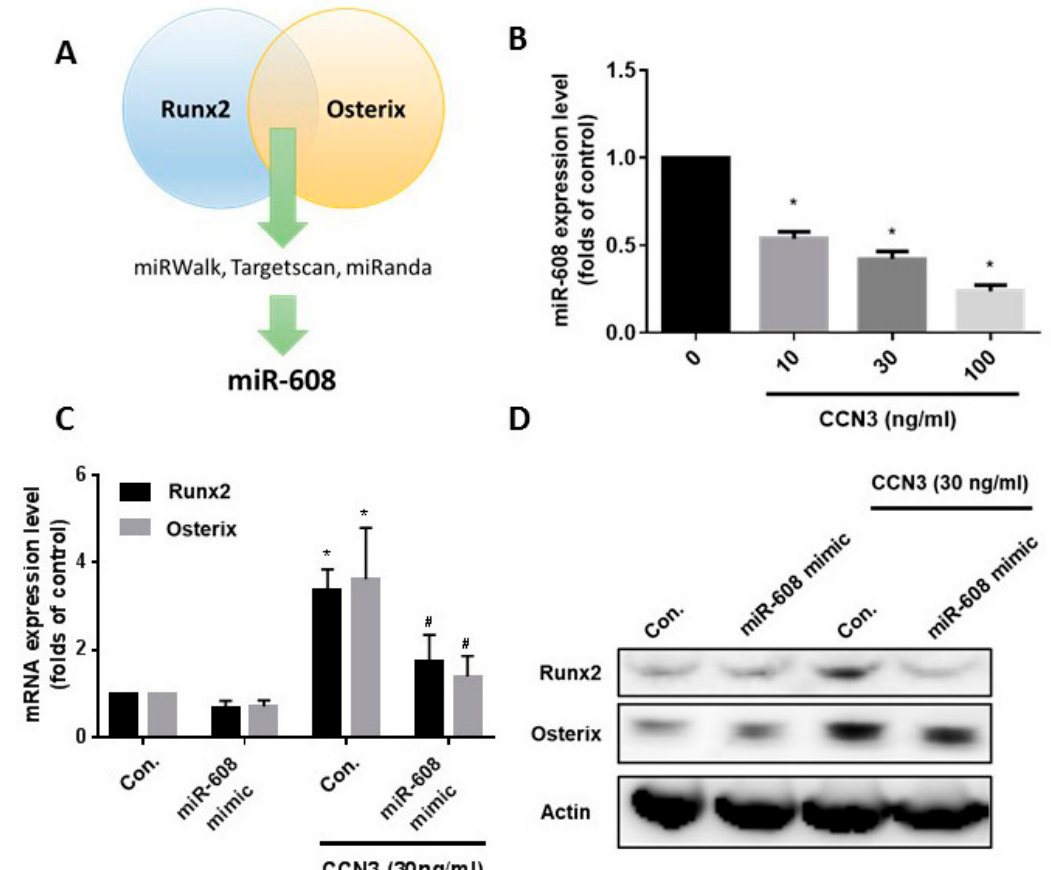
Figure 3. CCN3-induced suppression of miR-608 enhances Runx2 and osterix expression. ( A ) Open-source software (miRWalk, miRanda, and Targetscan) was utilized to identify microRNAs (miRNAs) that could possibly interfere with Runx2 and osterix transcription. ( B ) Osteoblasts were incubated with CCN3 for 24 h and miR-608 expression levels were examined by qPCR assay. Osteoblasts were transfected with miR-608 mimic and subsequently stimulated with CCN3. mRNA and protein expression of Runx2 and osterix were examined by qPCR ( C ) and Western blot assay ( D ), respectively. Results are expressed as the mean ± S.E. * p < 0.05 as compared with the control group; # p < 0.05 as compared with the CCN3-treated group.